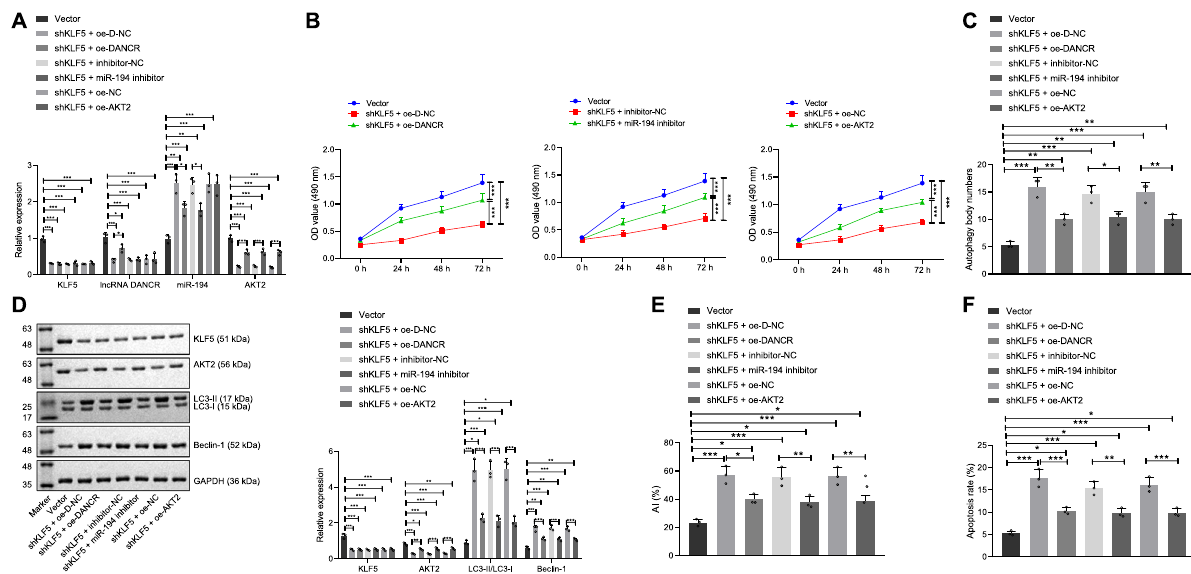
Fig. 6 KLF5 knockdown promotes GC cell autophagy by regulating the DANCR/miR-194/AKT2 axis. A qRT-PCR to measure the expression of KLF5, DANCR, miR-194, and AKT2 in transfected cells; B MTT assay to detect the viability of transfected cells; C quantitative analysis of autophagy of transfected cells under the observation of transmission electron microscope; D western blot assay to measure the expression of KLF5, AKT2, and autophagy-related proteins (LC3-I, LC3-II, and Beclin-1) in transfected cells; E TUNEL assay to detect TUNEL-positive apoptotic cells; F fl ow cytometry to evaluate the apoptosis rate of transfected cells. * p < 0.05, ** p < 0.00, *** p < 0.0001. The measurement data are summarized by mean ± standard deviation. Data in A , C – F were analyzed by one-way ANOVA with Tukey post hoc test. Statistical analysis in relation to time-based measurements in B was realized using repeated measures ANOVA, followed by a Bonferroni ’ s post hoc test. Cellular experiment was repeated three times.